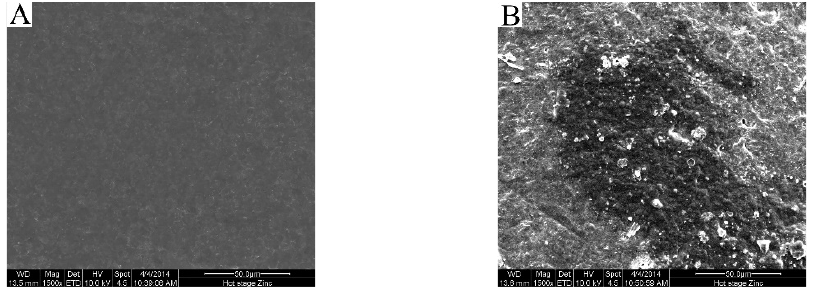
Figure 3. Outer surface SEM morphology of the HMR-PVDF membrane ( A ) initial, ( B ) adsorption.